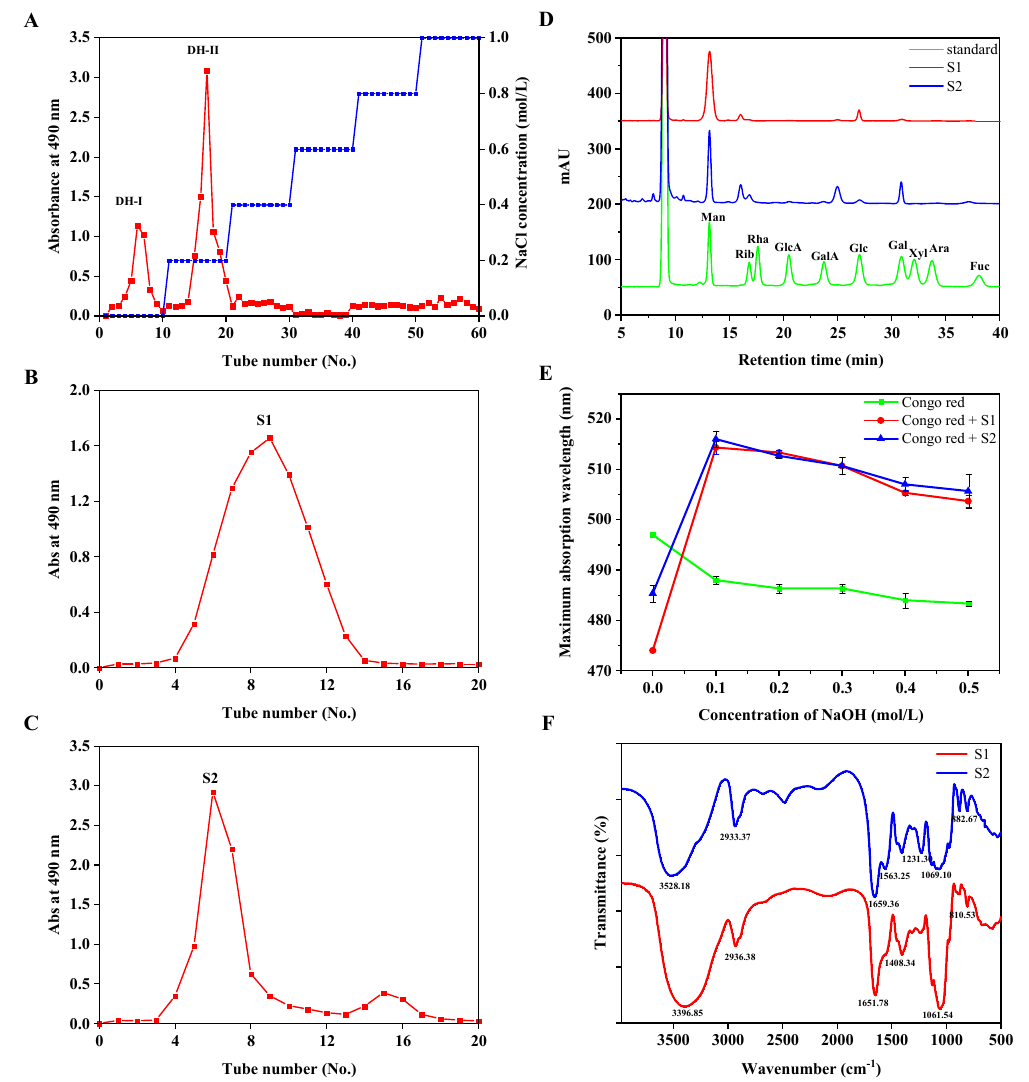
Figure 2. Column chromatographic separation and composition analysis. The crude EPS was sub- jected to gradient elution by DEAE sepharose cellulose fast-flow column ( A ), the red line represented the absorbance at 490 nm, and the blue line represented the concentration of NaCl. Two main peaks (DH − I, DH − II) were further purified by a Sephacryal S-100 column, obtaining two components named S1 ( B ) and S2 ( C ), respectively. ( D ) The HPLC chromatograms of the monosaccharide composition and peak identity. Man: Mannose; Rib: Ribose; Rha: Rhamnose; GlcA: Glucuronic acid; GalA: Galacturonic acid; Glc: Glucose; Gal: Galactose. Xyl: Xylose; Ara: Arabinose; Fuc: Fucose. ( E ) The maximum absorption wavelength of Congo red and polysaccharide samples at various concentrations of NaOH. ( F ) FT-IR spectrum of EPSs.